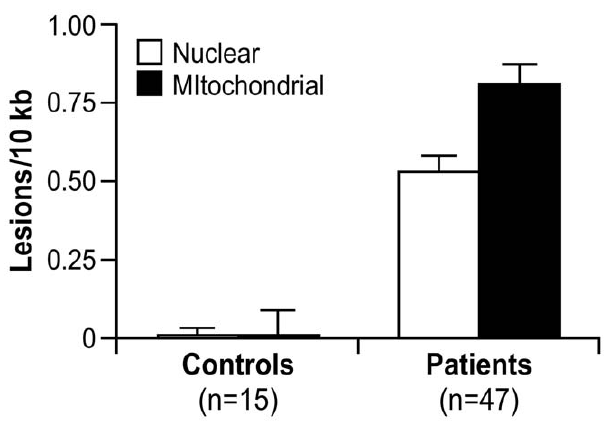
Figure 3. Nuclear and mitochondrial DNA damage are identi- fied by QPCR analysis of blood DNA from 47 patients with FRDA and 15 controls. These data represent the number of excess lesions found per 10 kb of DNA from both mtDNA and nDNA genomes in FRDA patients as compared to the controls. A significant number of nuclear (0.53 lesions/10 kb) and mitochondrial DNA lesions (0.81 lesions/10 kb) were observed ( p , 0.0001, respectively, by Mann- Whitney U test). There is a significantly higher number of mitochondrial lesions than nuclear lesions ( p , 0.002 by Mann-Whitney U test), and both types of lesions are highly correlated ( p , 0.0001 by Spearman’s Rank Correlation). Error bars represent the standard error of the mean.